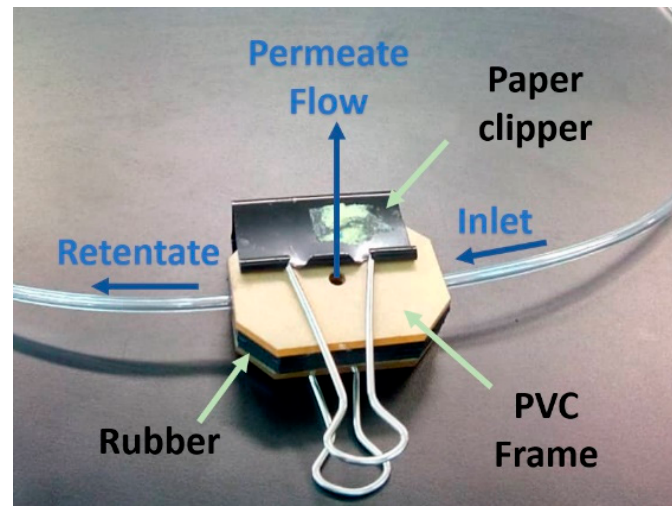
Figure 2. Membrane module with polyvinyl chloride (PVC) frame used for the microfiltration setup.